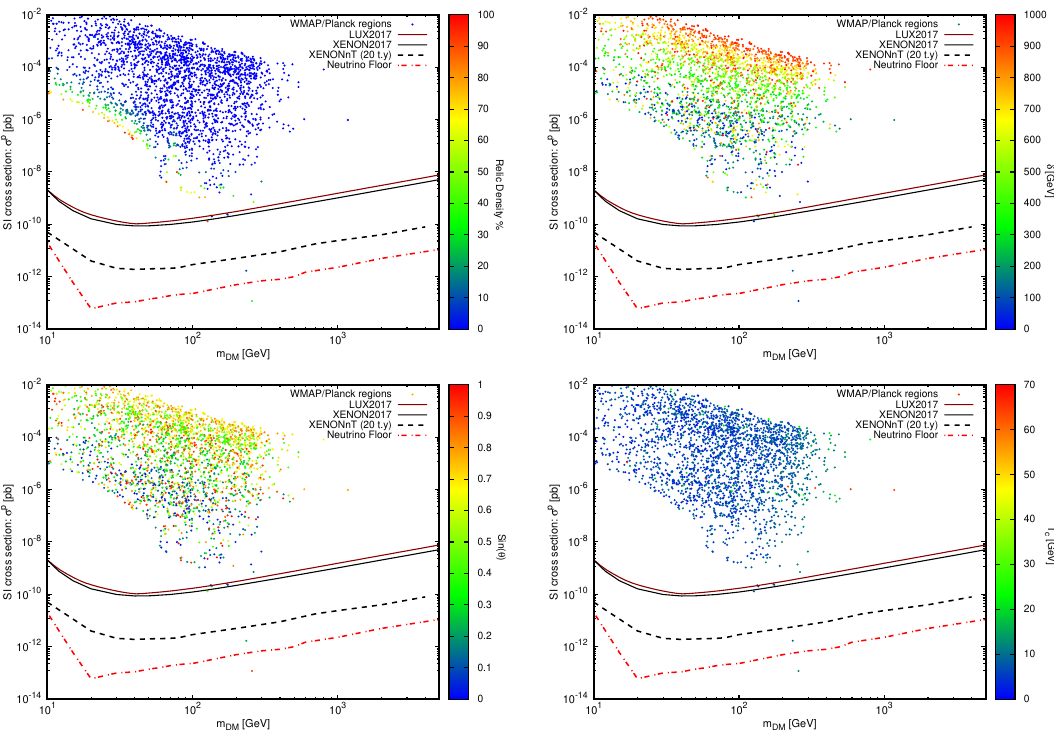
Figure 4 . Scenario 2.2.1 in model with the s - s 0 cross-coupling terms: in all plots, the spin- independent DM-proton elastic scattering cross section as a function of the DM mass are shown and compared with the DD experimental upper limits from LUX, XENON1T, XENONnT projections and the neutrino background. This phase transition channel has a narrow viable space respecting all the constraints but remarkably giving rise to a DM model which consists 75% of the DM relic density. The vertical color spectrum in the plots indicates, upper-left) the fraction of the observed relic abundance, upper-right) the mass splitting (cid:14) , lower-left) the variation of the mixing angle sin (cid:18) and lower-right) the critical temperature T c